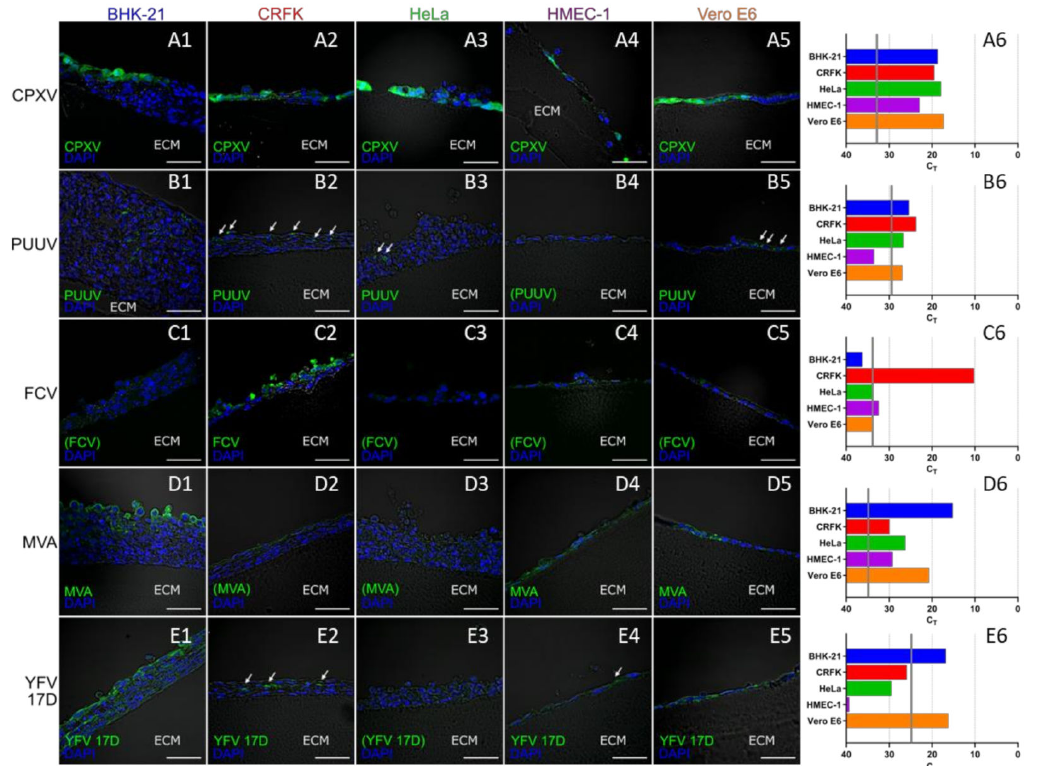
Figure 5. Permissiveness of di ff erent cell lines cultured on Wellbricks for infection with di ff erent viruses. The cells were cultivated on Wellbricks (10 wt% gelatine, w / o Collagen A) for 3 days and subsequently infected either with Cowpox virus (CPXV ) for 48 h ( A1 – A6 ), Puumala virus (PUUV) Kazan for 96 h ( B1 – B6 ), Feline calicivirus (FCV) for 24 h ( C1 – C6 ), Modified Vaccinia Ankara (MVA) for 72 h ( D1 – D6 ), and Yellow Fever virus (YFV) 17D 72 h ( E1 – E6 ). The 8- µ m cryosections of the specimens were analysed by fluorescence microscopy (1–5). After permeabilisation, infected cells were visualised with virus-specific antibodies and AF647-coupled anti-rabbit or anti-mouse secondary antibodies (green) ( B1 – B6 ) – ( E1 – E6 ). CPXV-infected cells were visualised by monitoring GFP expression (green) from recombinant CPXV ( A1 – A6 ). Cellular nuclei were counterstained with DAPI (blue). White arrows indicate elusive spots of infected cells, scale bar = 50 µ m. The micrographs shown are representative for data from several sections analysed. Average cycle threshold (C T ) values for virus genome equivalents in cell lysates of infected cells ( n = 2) were determined by virus-specific qPCRs (6). C T values corresponding to the respective inocula are indicated as vertical grey